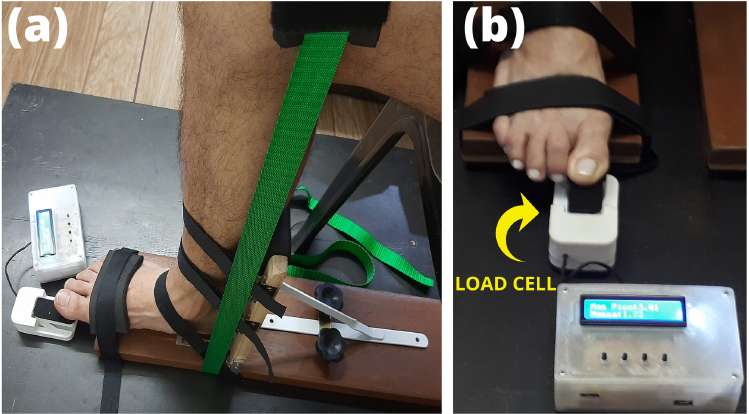
Figure 1. Measurement of hallux flexor muscles with a wooden platform: ( a ) setup to stabilize the ankle–foot complex and knee; ( b ) load